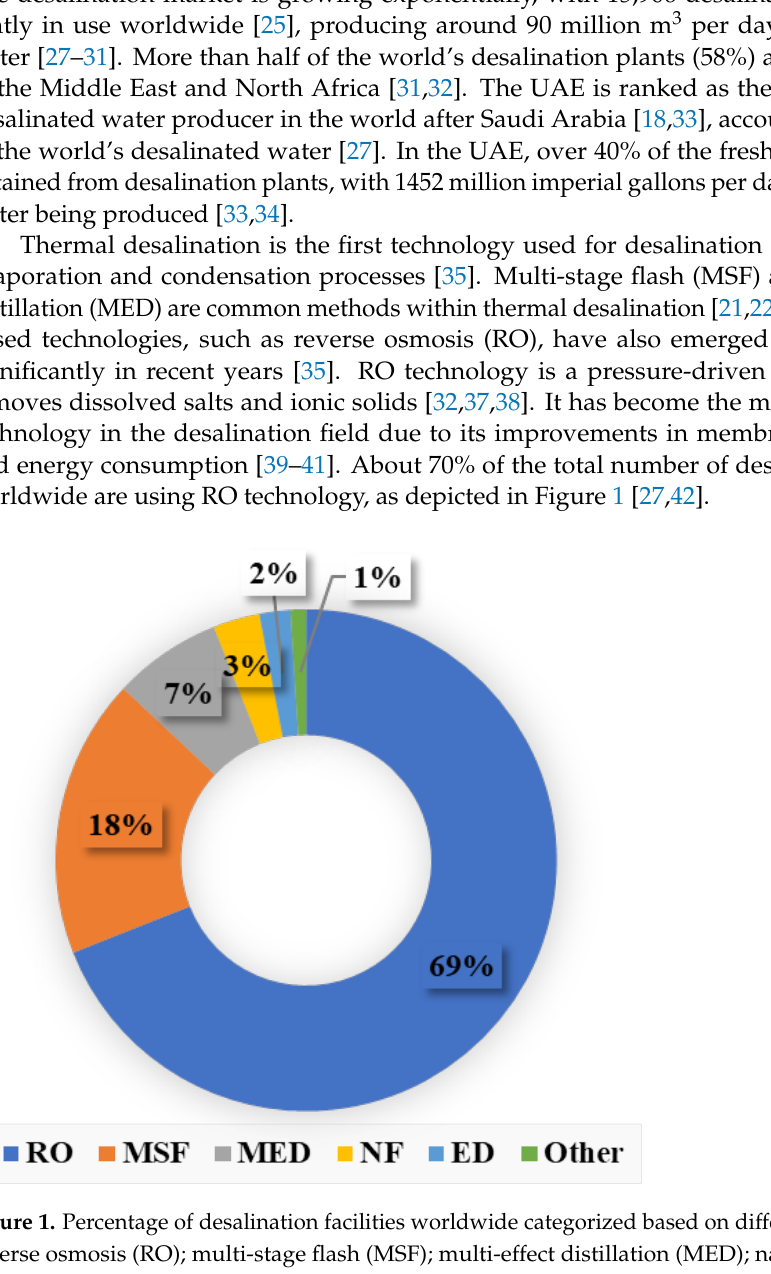
Table 2. General characterization of seawater in the UAE [26].